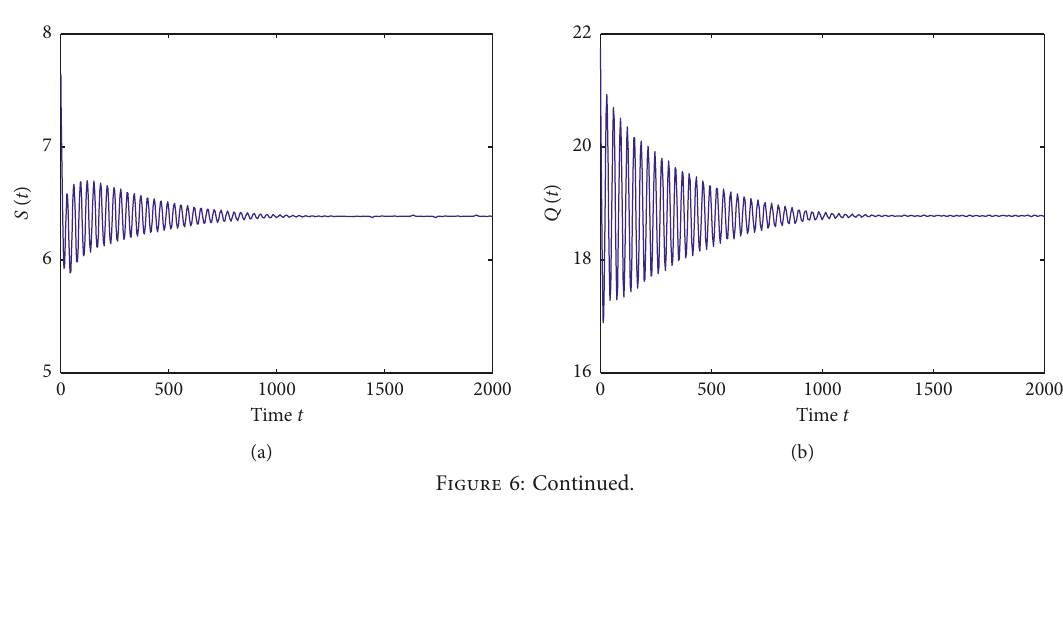
. 9608 2 (cid:31) 23